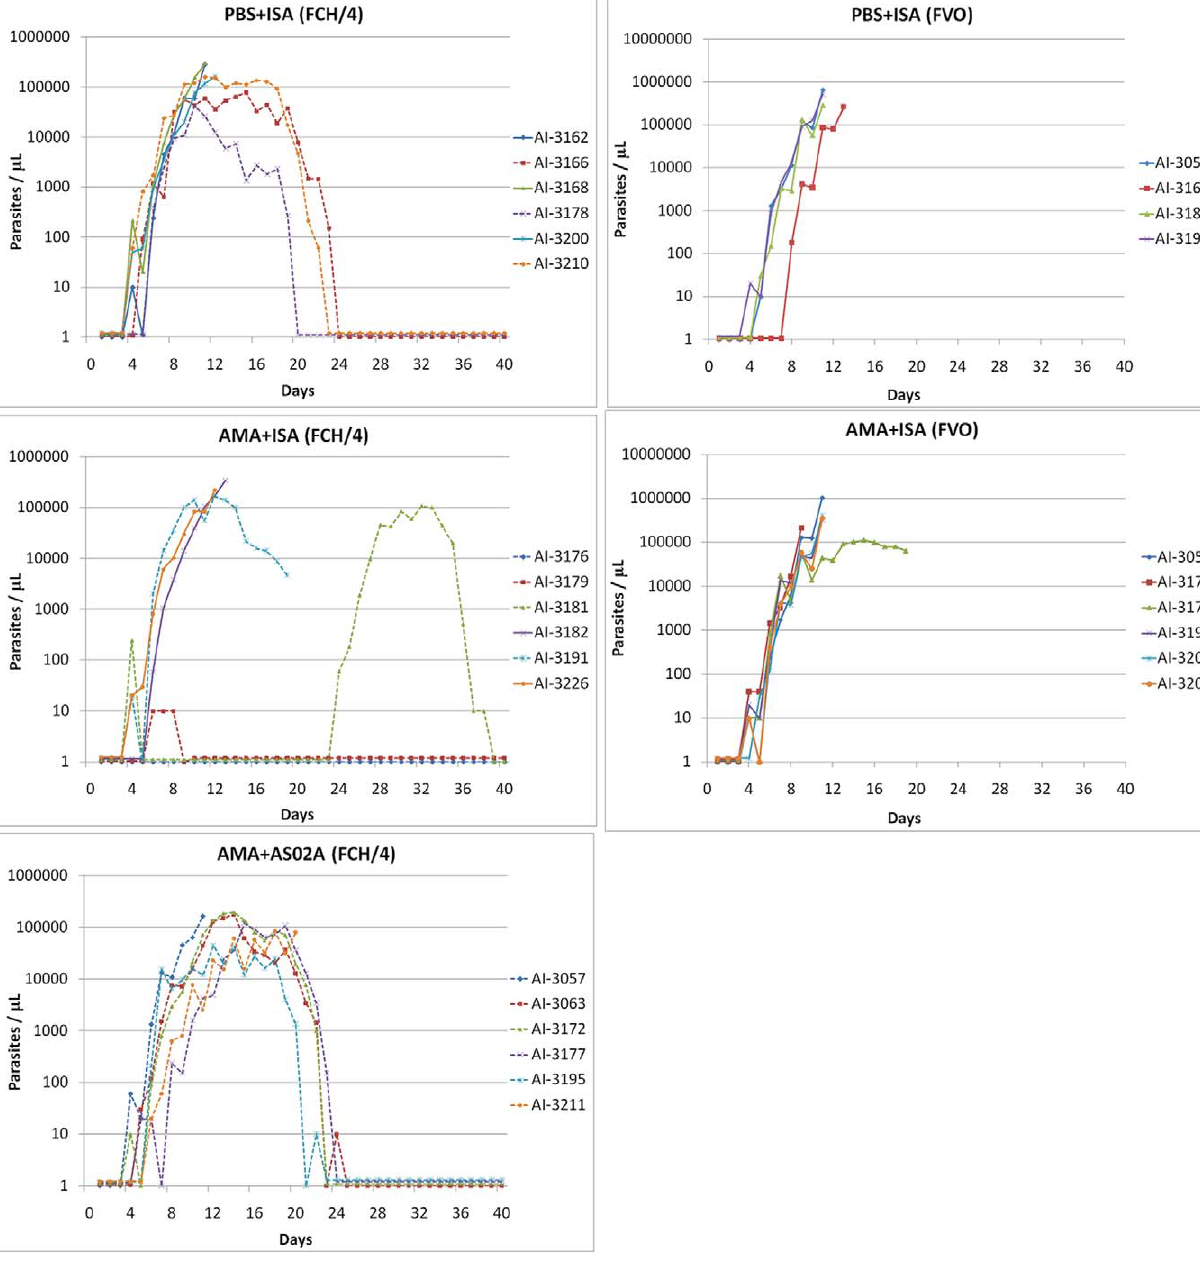
Figure 4. Parasitemia profiles of FCH/4 and FVO challenged groups. Daily parasitemia of animals plotted against days-post-challenge (days). Solid lines represent a virulent parasitemia profile that required drug treatment for high parasitemia ( . 200,000/ m L) within 15 days of challenge. Broken lines represent a slower progressing and self-limiting infection profile. The challenge strains are indicated in parentheses (FCH/4 or FVO). Two monkeys in the AMA + ISA FCH/4 group (AI3181, AI-3176) were re-challenged on day